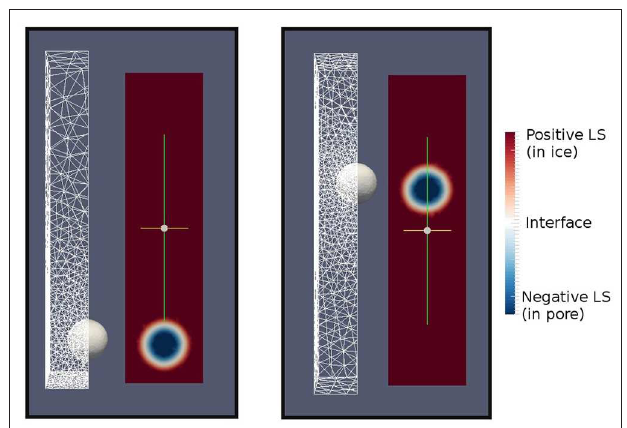
FIGURE 5 | Advection of a sphere. The left and right panels, respectively display the start and end the simulation. In each panel: the left part is the side view of the structure with the surface of the sphere in gray and the mesh of the exterior ice in white. The right part is a cross section of the column showing the LS function. Red colors represent the ice phase and blue colors the pore phase.